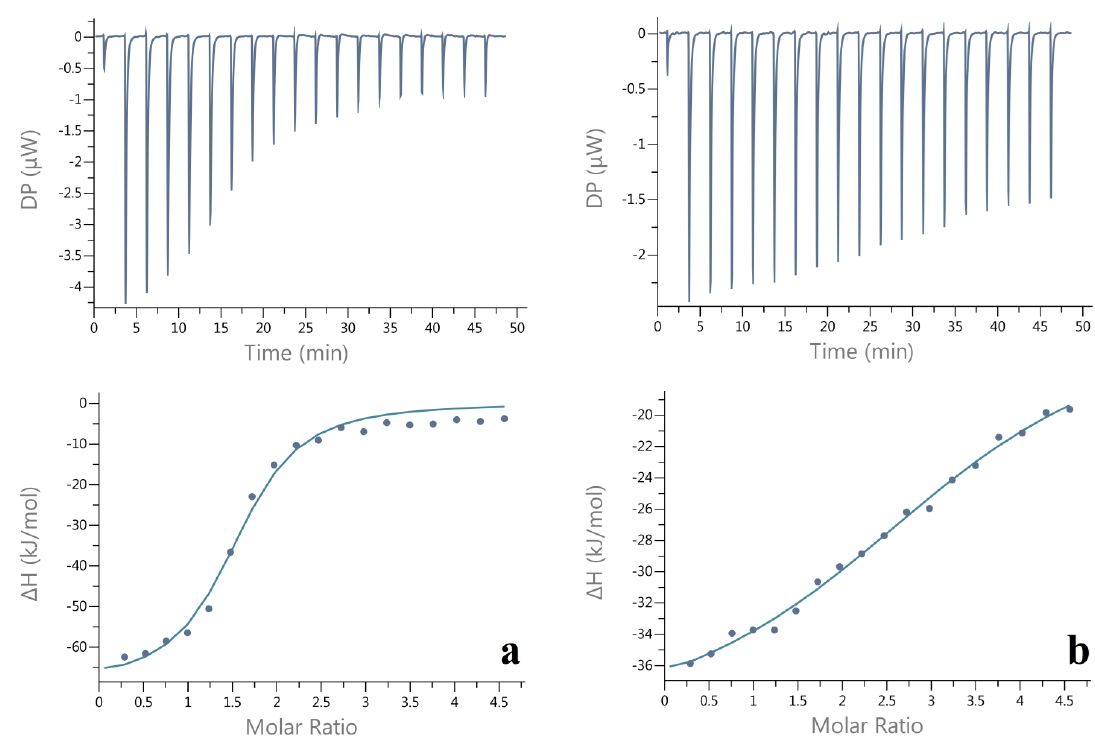
Figure 7. Thermogram (upper panel) and binding isotherms with theoretical fits (lower panel) of the titration of CMI into BSA at pH 4.00 ( a ) and pH 2.60 ( b ), respectively (C NaCl = 10mM).